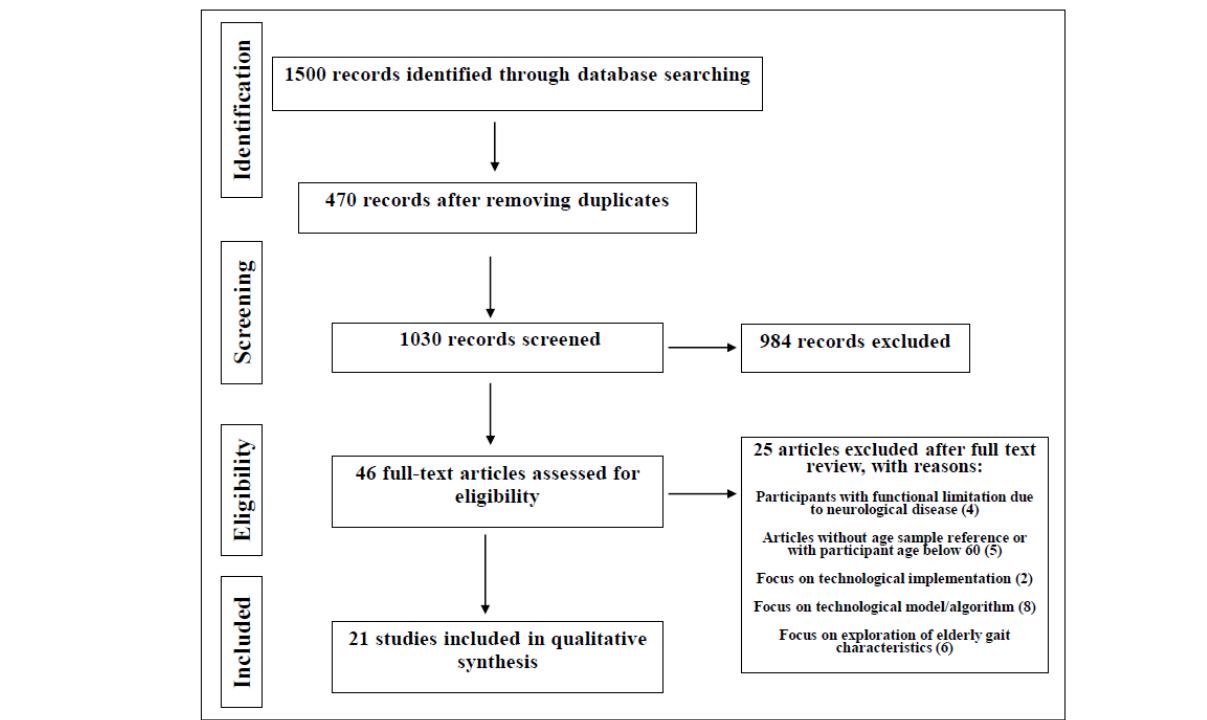
Figure 1. Flow of selection for studies included and excluded in the